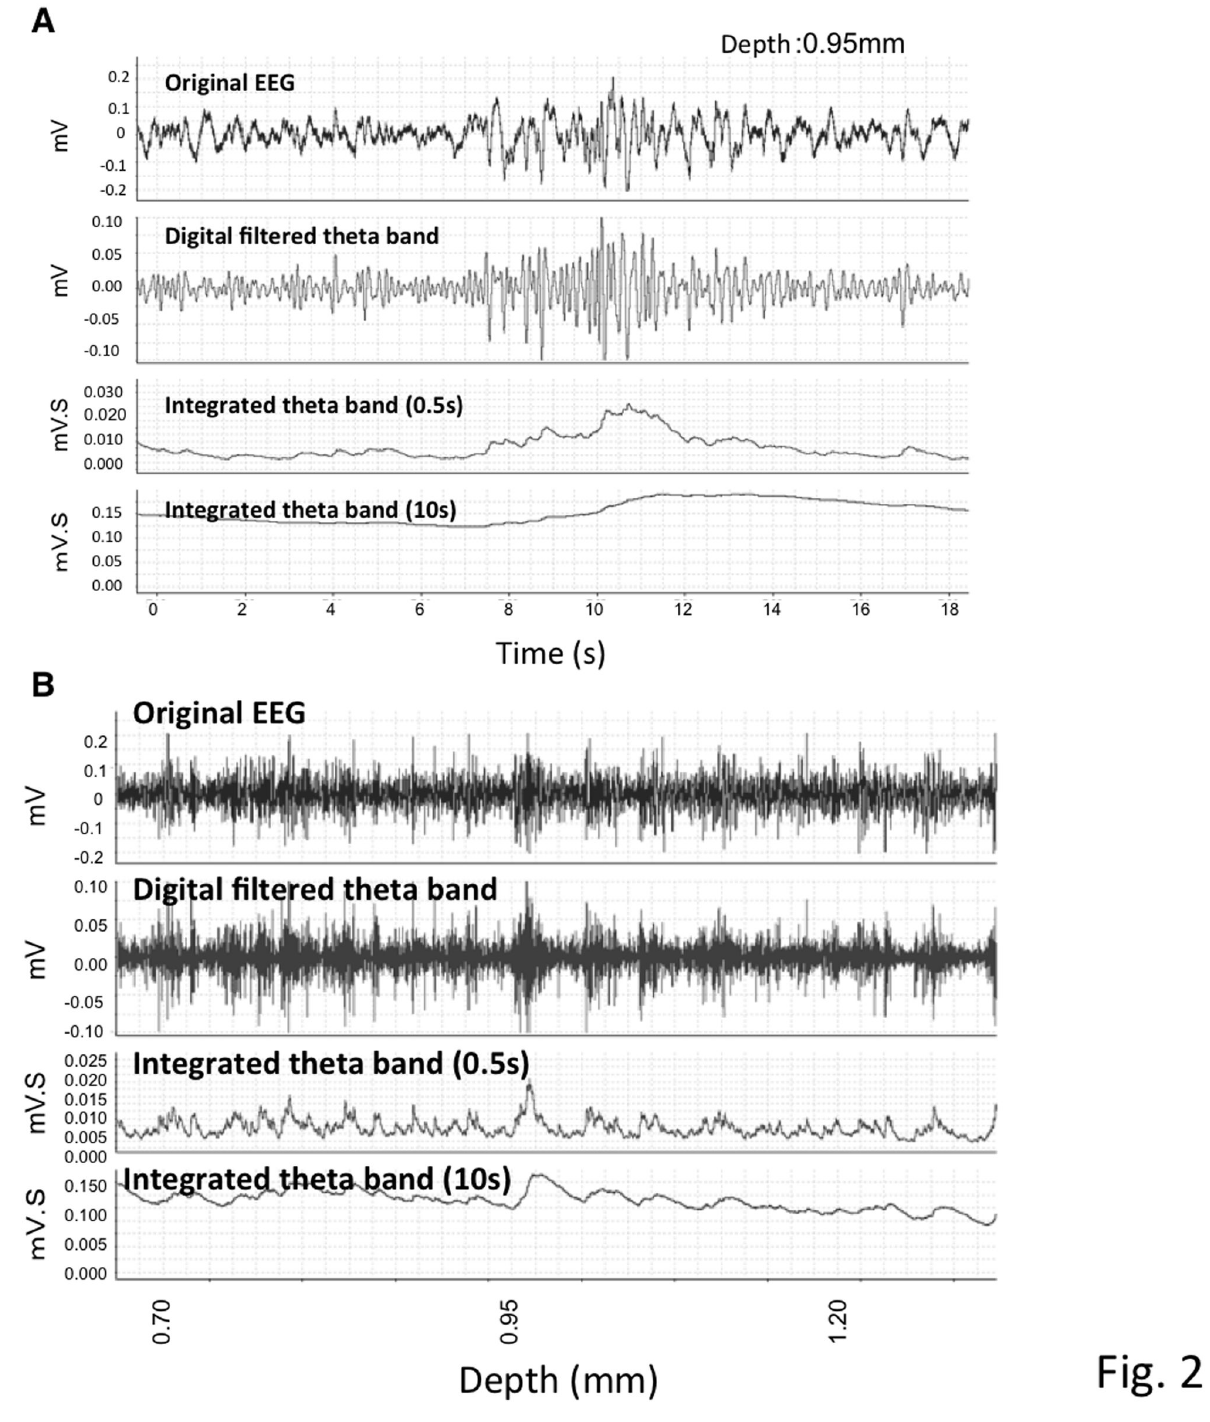
Figure 2. Representative EEG data. A . Raw EEG data collected from a recording electrode (top) and filtered EEG after selecting for theta oscillations (4-8 Hz) (middle). An isolated theta oscillation in a 10 sec and 20 sec bin was analyzed using integrated values (0.5 sec and 10 sec durations) at a depth of 0.95mm from the cortex. B . Sequential recording of EEG at different depths. The same three types of data are presented as in Figure 2A with changes at different depths indicated at the bottom. Twenty seconds of recording data at each depth were collected, analyzed, and integrated over 0.5 sec and 10 sec. doi: 10.1371/journal.pone.0083129.g002 PLOS ONE |